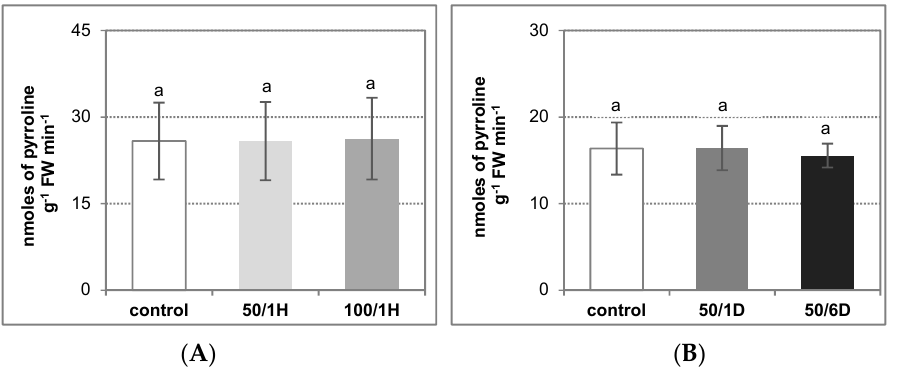
Figure 3. Diamine oxidase activity in the tissues of cucumber roots treated with: ( A ) 50 mM or 100 mM NaCl for 1 h (50/1H and 100/1H, respectively); ( B ) 50 mM NaCl for 1 or 6 days (50/1D and 50/6D, respectively). DAO activity was assayed in the roots, as described in Materials and Methods. The presented results are the means ± SD of three independent experiments, with each experiment performed in triplicate, and are expressed as nmoles of Δ 1 -pyrroline g − 1 FW min − 1 . Means with the same letter are not significantly different ( p < 0.05).